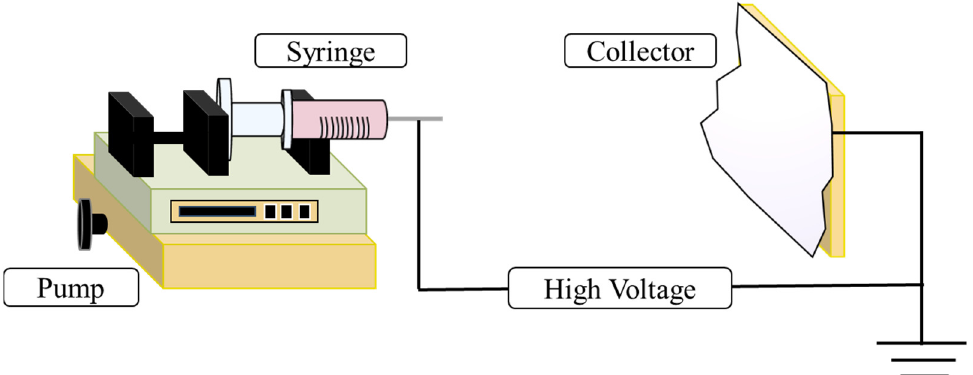
Figure 1. Schematic representation of the electrospinning set-up.